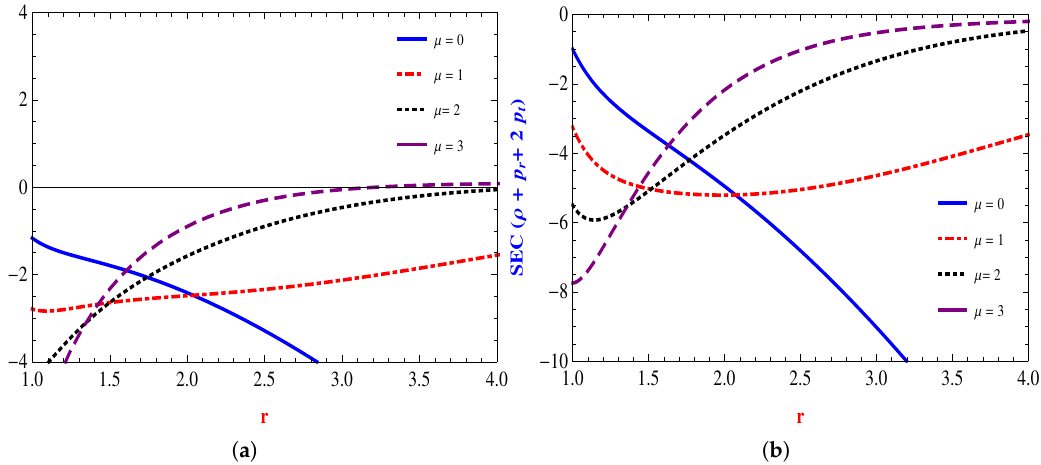
Figure 2. Plots: ( a ) Tangential NEC ( ρ + p t ) and ( b ) SEC ( ρ + p r + 2 p t ) with throat radius r 0 = 1 and α = 1 in f ( Q ) = α Q gravity.